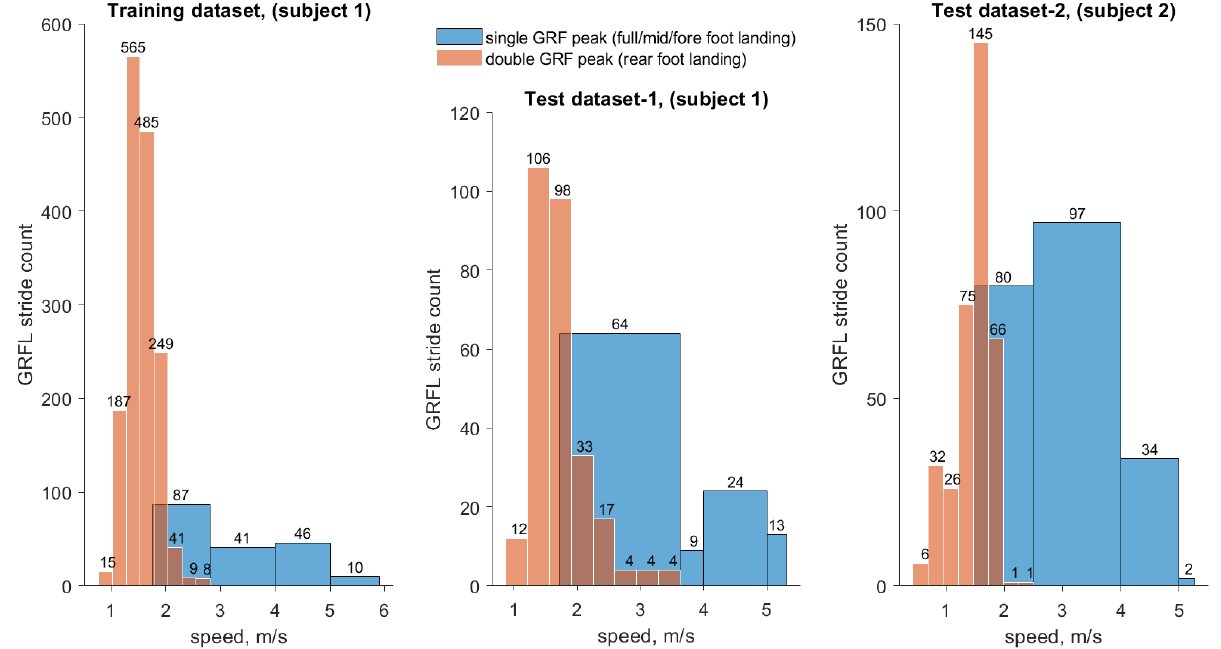
Figure 7. Speed-stride histograms for training set and both test